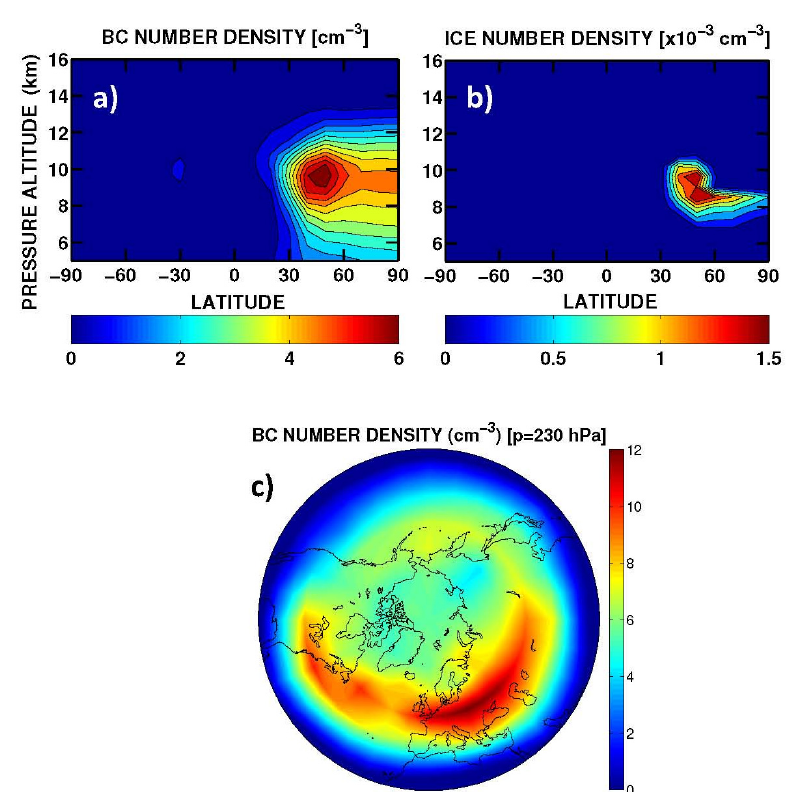
Figure 6. Top panels: zonally and annually averaged aircraft perturbations of soot number density (left panel ( a )) and soot cirrus number density (right panel ( b )), due to aviation emissions and calculated in the ULAQ model. Bottom panel: as in panel (a), but for the lat/lon map at p = 230 hPa (cm − 3